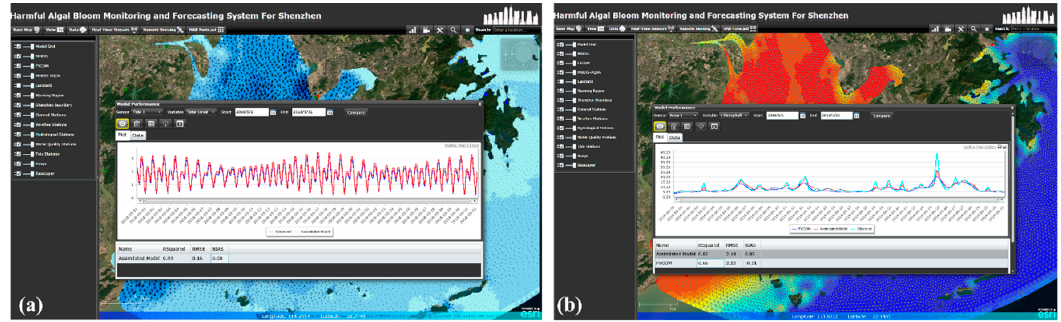
Figure 11. Model performance tool: ( a ) Comparison of observed and assimilated tidal levels at a tide station; ( b ) Chl-a comparison among free model run, assimilated model run and in situ observation during the period 1 May to 31 May at a water quality sampling station.